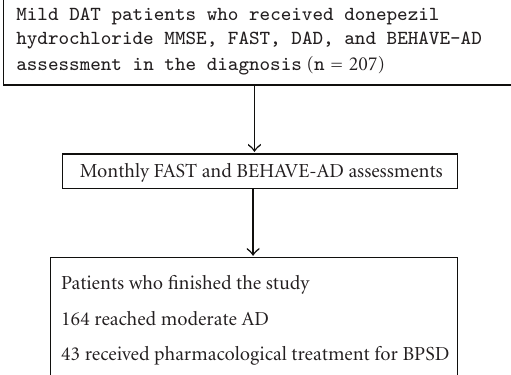
Figure 1: Study flow chart. MMSE: Mini-Mental State Exam- ination; FAST: Functional Assessment Staging; DAD: Disability Assessment for Dementia; BEHAVE-AD: Behavioral Pathology in Alzheimer’s Disease Rating